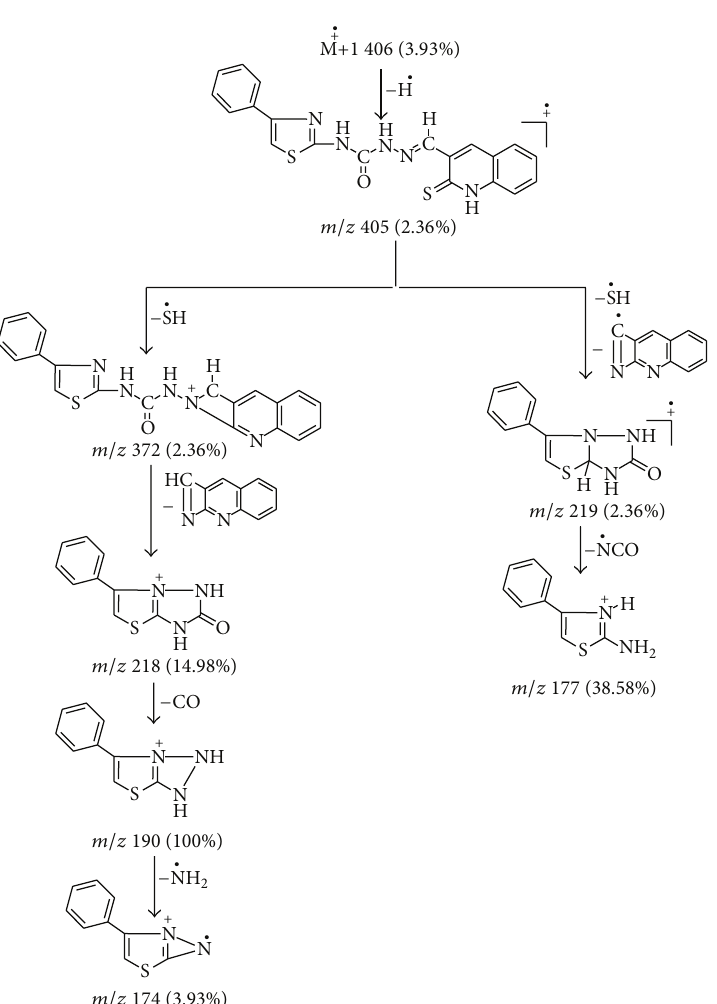
Scheme 2: Mass fragmentation pattern of Schiff base ligand (L)